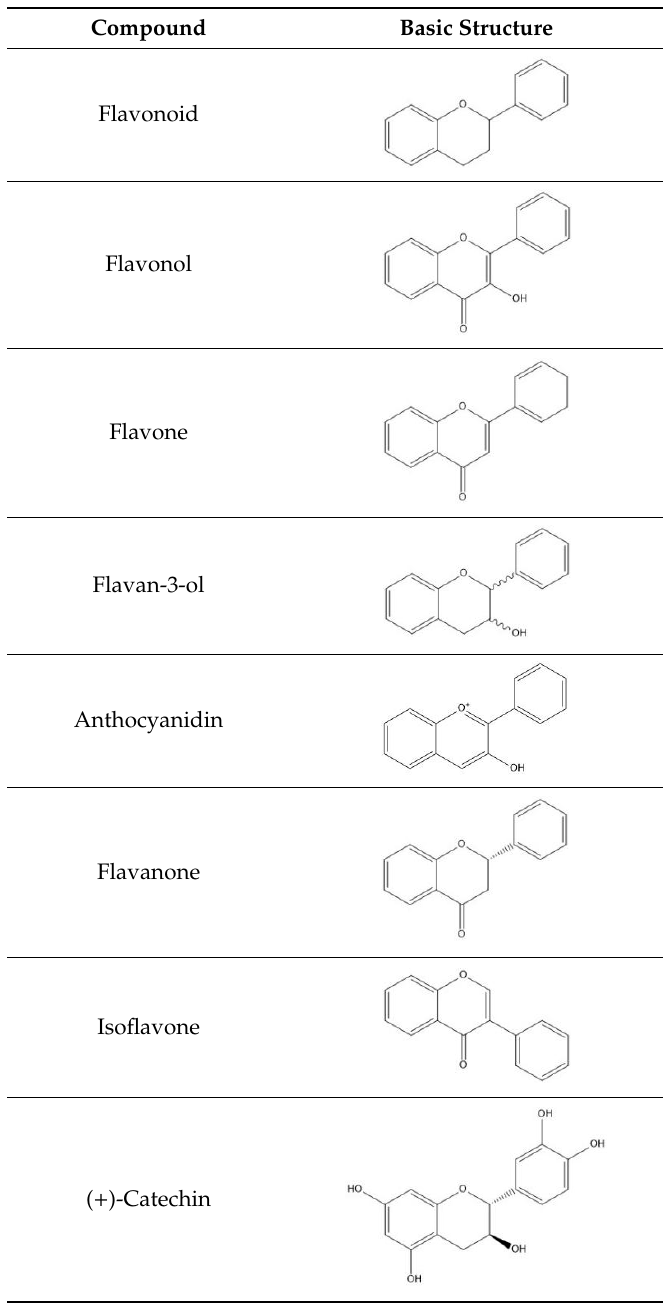
Table 1. The basic structure of flavonoid, its main subclasses, and the majority of proanthocyanidins (PAs).